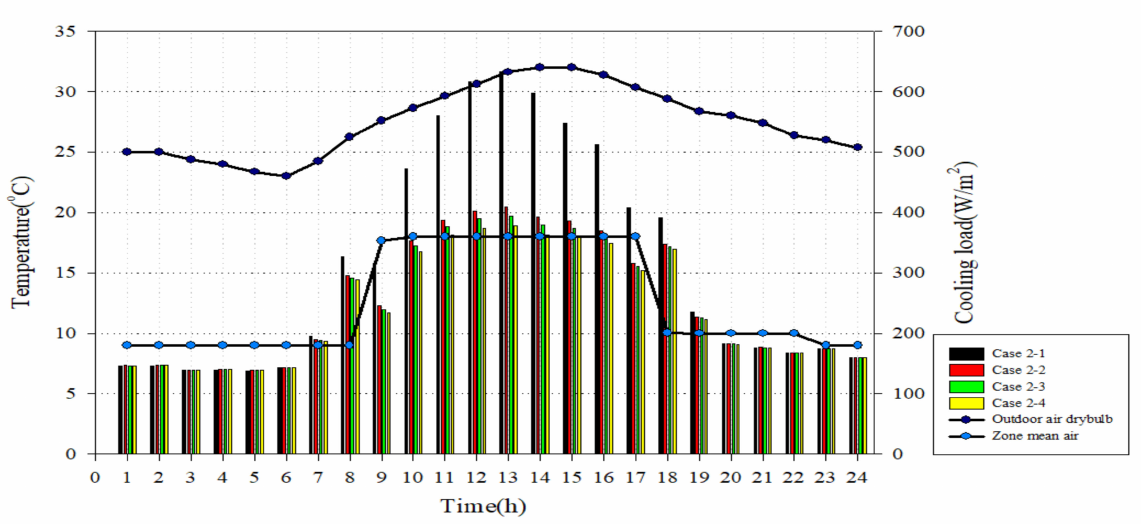
Figure 20. Cooling load changes according to internal shading rate control (Case 2-1 through